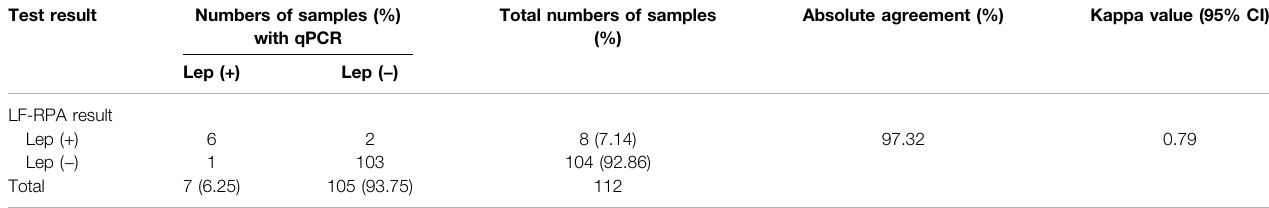
TABLE 3 | Concordance between EuNPs-LFIC-RPA and qPCR tests in specimens for detection of Legionella pneumophila . Test